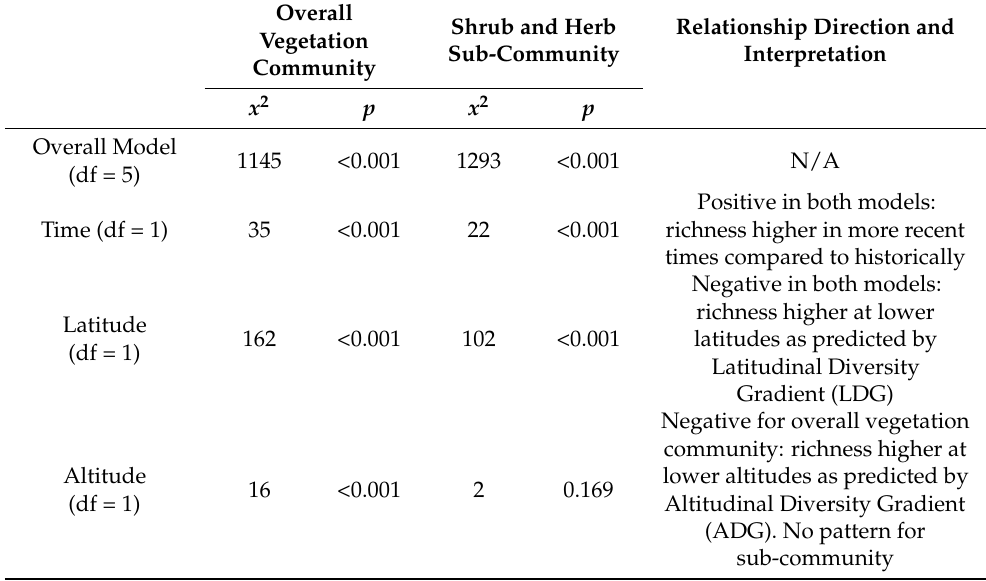
Table 1. Generalised Linear Models of taxonomic richness in relation to spatiotemporal variables. Chi square values are likelihood ratio for the overall models and Wald for factors and interaction